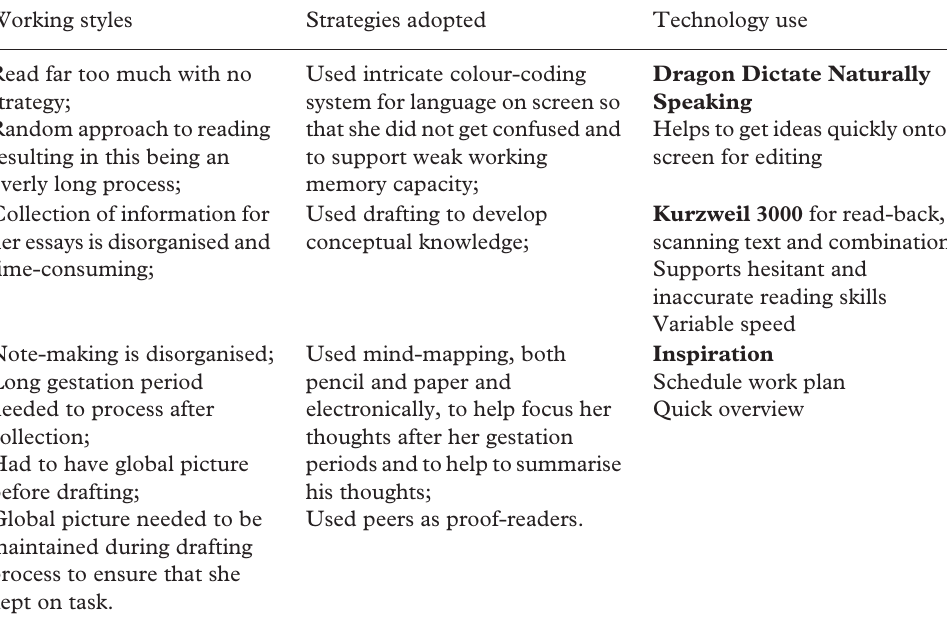
Table 3. Summary of strengths, technology and modal preferences of Student C Working styles Strategies adopted Technology